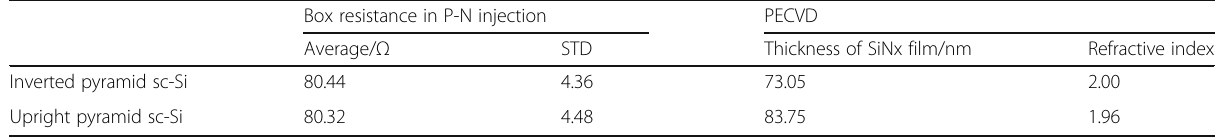
Table 1 Comparison of box resistance in P-N injection and PECVD effect between inverted and upright pyramid